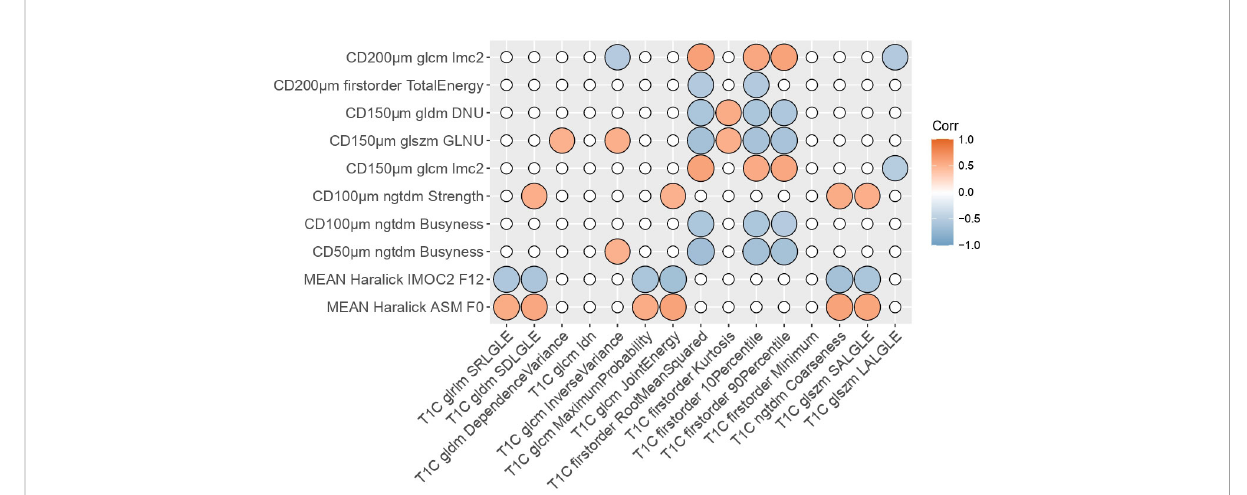
FIGURE 3 Radiopathomic analysis between T1C radiomic features and pathomic features. Correlation matrix fi ltered from nonsigni fi cant correlations (rows and columns with non-signi fi cant values were deleted, while surviving nonsigni fi cant values were set to zero). DNU, Dependence non uniformity; GLNU, gray-level non-uniformity; IMOC, Information Measure Of Correlation; ASM, Angular Second Moment; SRLGLE, Short Run Low Gray Level Emphasis; SDLGLE, Small Dependence Low Gray Level Emphasis; T1C, post-contrast T1; SALGLE, Small Area Low Gray Level Emphasis; LALGLE, Large Area Low Gray Level Emphasis; glcm, gray level co-occurrence matrix; gldm, Gray Level Dependence Matrix; glszm, Gray Level Size Zone Matrix; ngtdm, Neighbouring Gray Tone Difference Matrix; glrlm, Gray Level Run Length